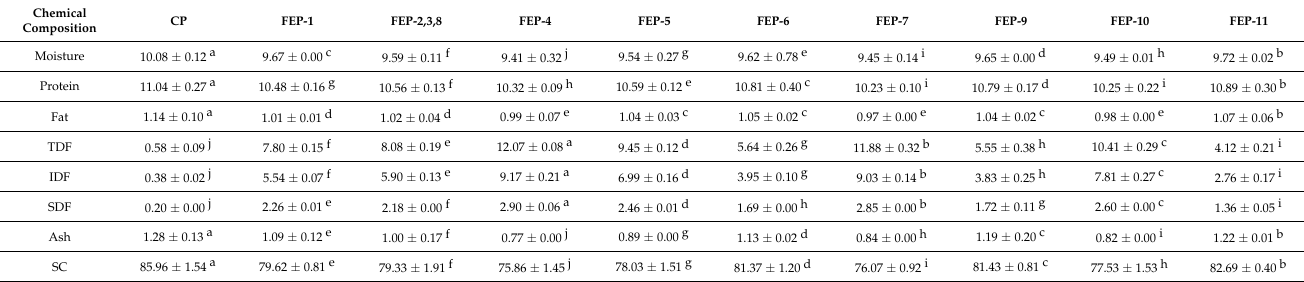
Values are means ± SD. Means within a row with different superscript letters are significantly different ( p < 0.05). FEP-2,3,8 is the center point, and their value is the average of the three central points. TDF: total dietary fibers; IDF: insoluble dietary fibers; SDF: soluble dietary fibers; SC: soluble carbohydrates, CP: control pasta. The TDF content of FEP varies significantly ( p < 0.05) between the experimental pastas. All FEPs contain more TDF than CP, which increased 7 to 21 times over CP (Table 3 and Figure 1A).